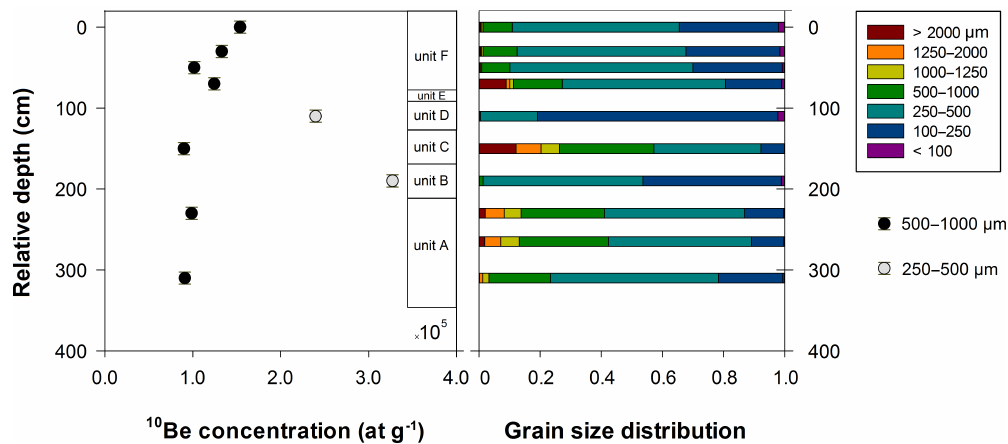
Figure 6. 10 Be concentration profile and results of the grain size analysis. Note that the elevated 10 Be concentrations belong to samples that were analyzed using a smaller grain size fraction than the other samples (i.e., 250–500µm instead of 500–1000µm). These are indicated by pale gray dots. Depth is given relative to the uppermost